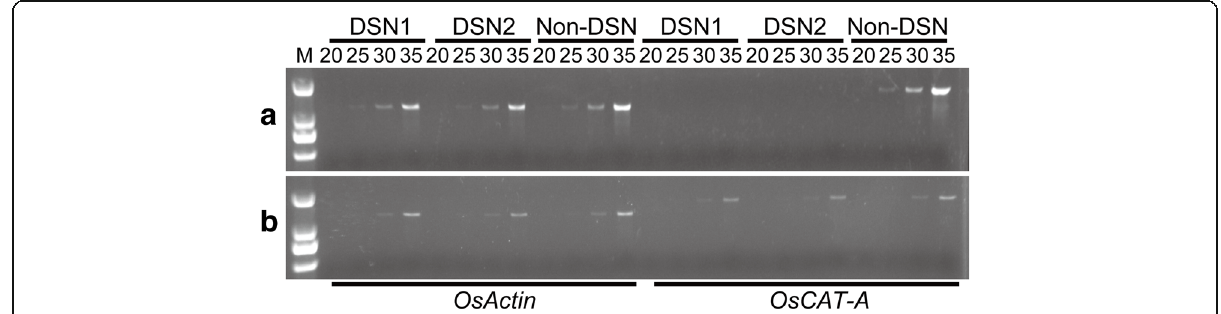
Fig. 2 Hybridization buffer prevented complete denaturation of cDNAs. The driver with hybridization buffer ( a ) or 10 mM Tris-HCl ( b ) were denatured at 98 °C for 2 min, and then treated with DSN at 68 °C for 10 min and subsequently inactivated at 98 °C for 5 min. Using denatured driver cDNAs as template, genes OsActin and OsCAT-A were amplified by gene-specific primers. Aliquots of PCR reaction mixture were taken at 20, 25, 30, and 35 cycles of amplification and the products were analyzed on 1% agarose gels as indicated. “ DSN1 ” and “ DSN2 ” represent repeated treatment with DSN, and “ Non-DSN ” indicates samples without DSN treatment in the reaction mixture. Lane M, DNA ladder (Generay. Code No.